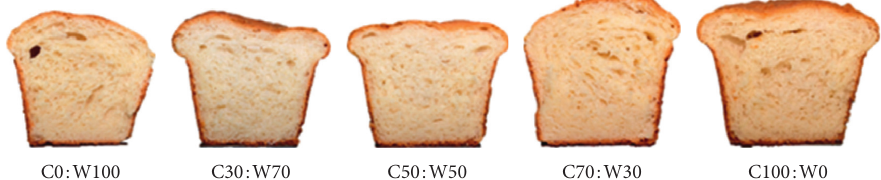
Figure 1: Samples used for the sensory evaluation of bread. C0: W100: 100% water (control), C30: W70: 70% water and 30% camel milk, C50: W50: 50% water and 50% camel milk, C70:W30: 30% water and 70% camel milk, and C100:W0: 100% camel